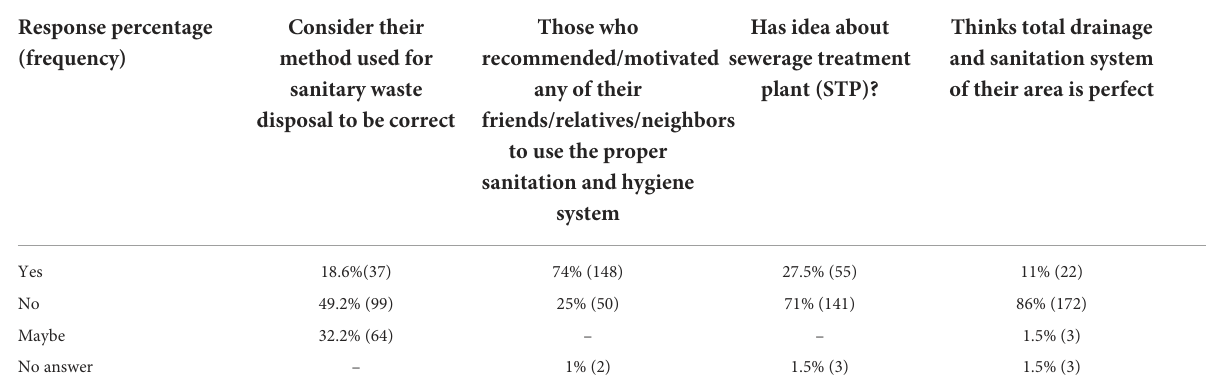
TABLE 4 Status of sanitation for non-slum